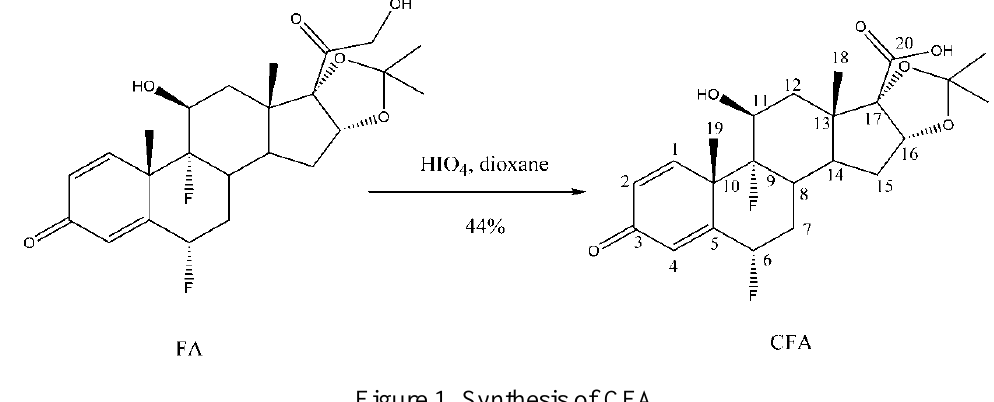
Figure 1. Synthesis of